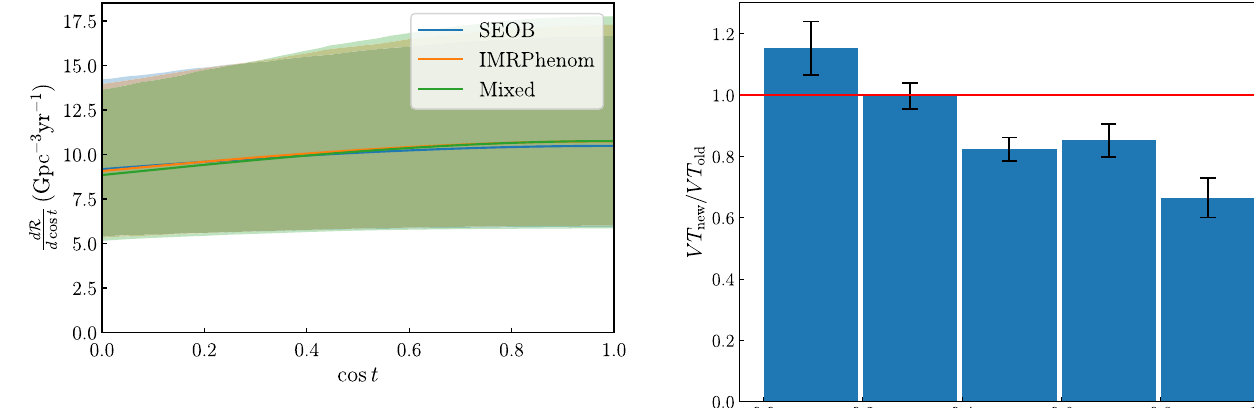
FIG. 26. Inferred differential merger rate as a function of the cosine of the tilt angle ( t ), where i indexes the body of the binary. i We demonstrate that the differences in the posterior distribution FIG. 27. Comparison of our current BBH merger sensitivity for GW200129 ’ s spin parameters have a minimal effect on the estimate in the O3a observing run ( VT ) to that used in new inferred spin-tilt population. The population is inferred using Ref. [20] ( VT ) as a function of redshift, for events with chirp old posterior distributions for GW200129 using the IMRPhe- masses between 20 and 50 M ⊙ . Our current sensitivity model nomXPHM waveform model (orange), SEOBNRv4PHM model differs from what was used in Ref. [20] in two important ways: (blue), and a mixture of both (green). Dashed lines are 90% We use updated detection pipelines relative to those used in our credible intervals. GWTC-2 [20] and we use injections which include spin pre- cession. There is a relative increase (decrease) in sensitivity at low (high) redshift. Computed by reweighting injections to a fiducial population for each of the two injection